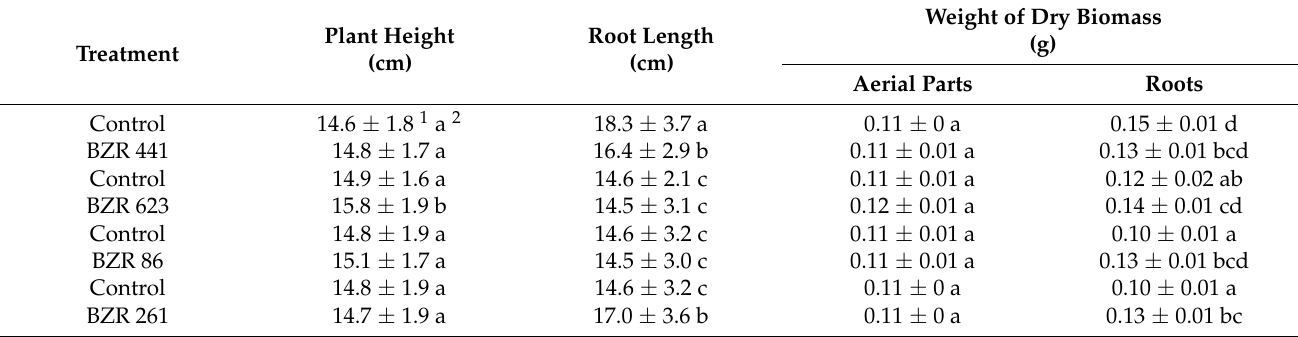
Table 2. Effect of bacterial strains on growth and biomass of winter wheat plants (cv. Batko) in the pot experiment.